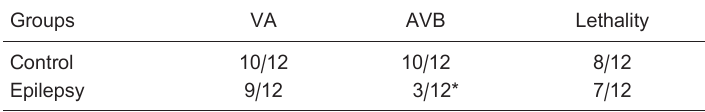
Table 1. Incidence of ventricular arrythmias (VA), atrioventricular block (AVB) and lethality during reperfusion in 12 rats in each